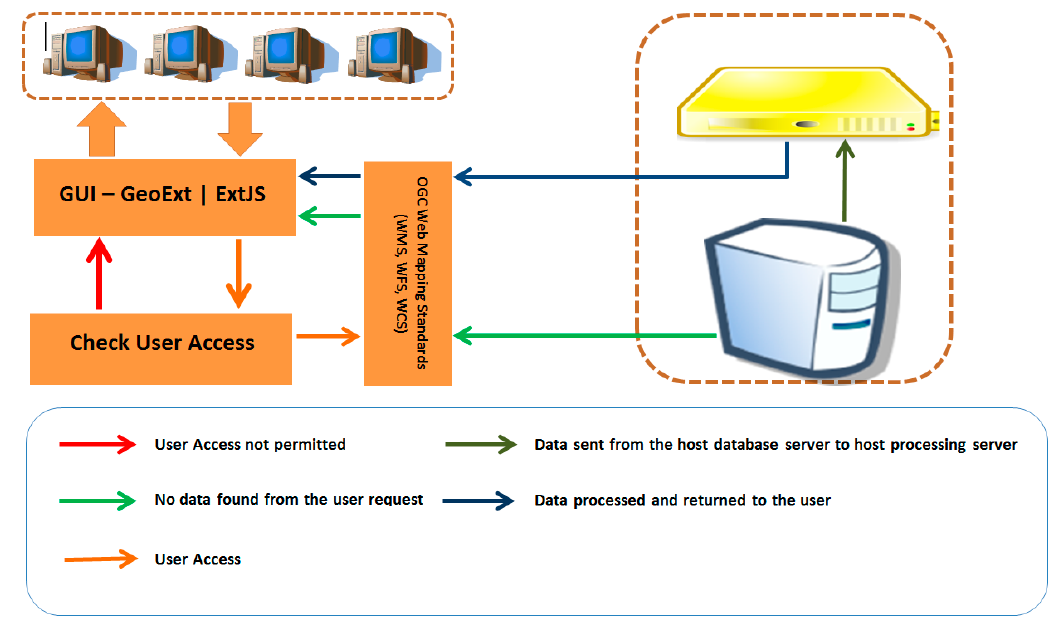
Figure 3. Data access restrictions. Data interoperability is achieved using Open Geospatial Consortium (OGC) standards. However, access to sensitive datasets is restricted at the user level.